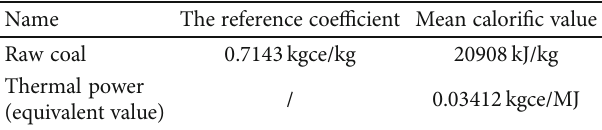
Table 7: The reference coe ffi cient of converting various energy into standard